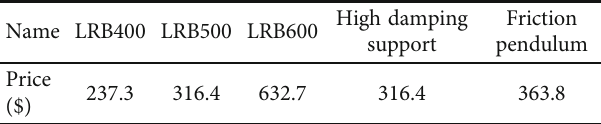
Figure 9: Comparison of fl oor acceleration between the seismic-resistant model and the seismic isolation models under seismic waves. Table 4: Isolation support price information.